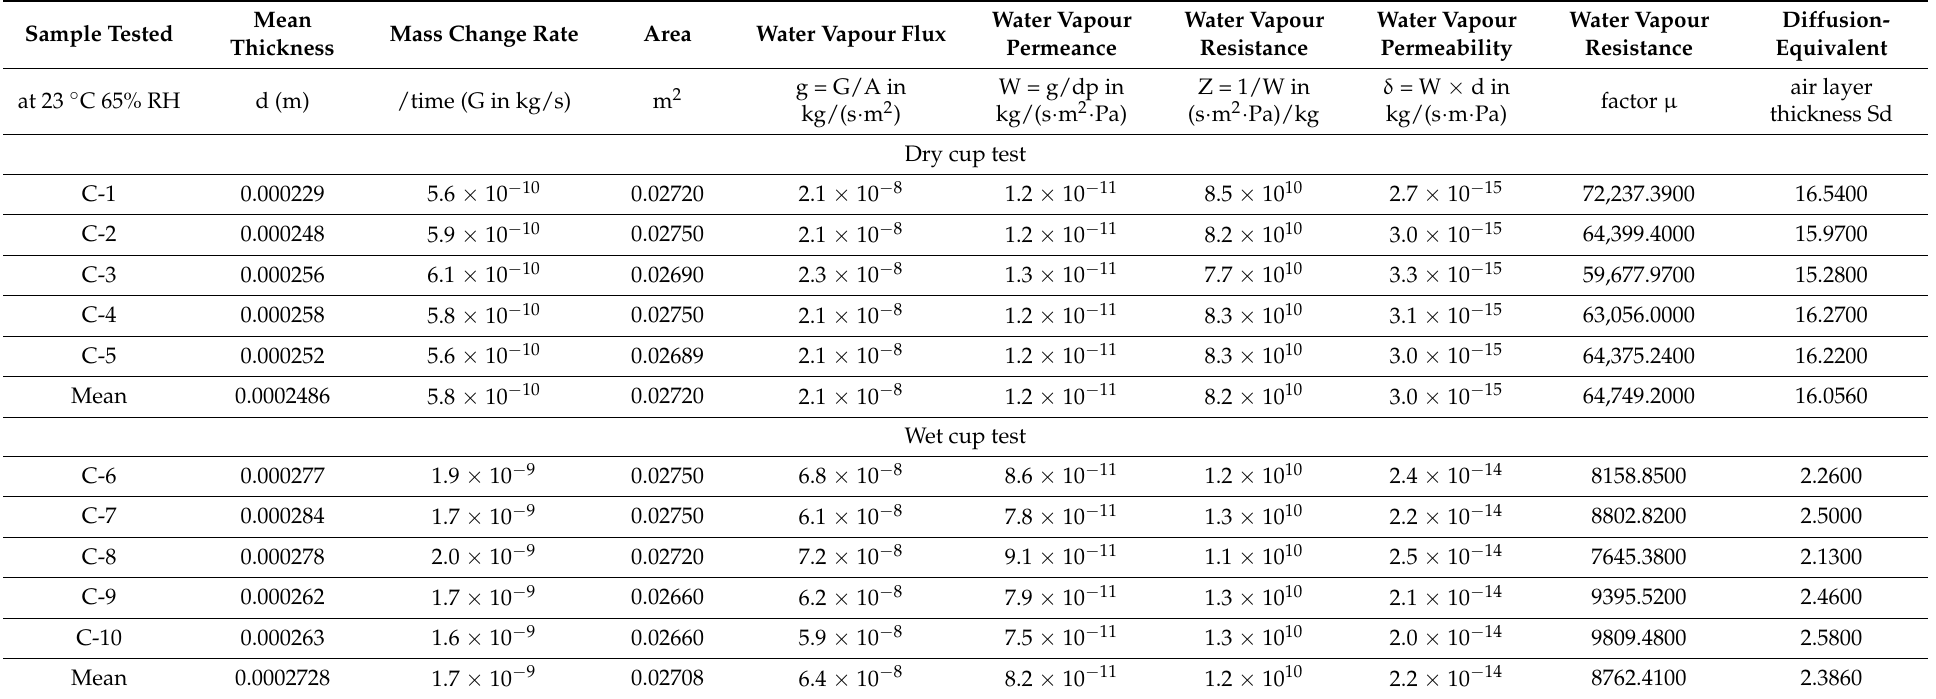
Table A4. Water vapour resistivity properties of sample C at 23 ◦ C 65%